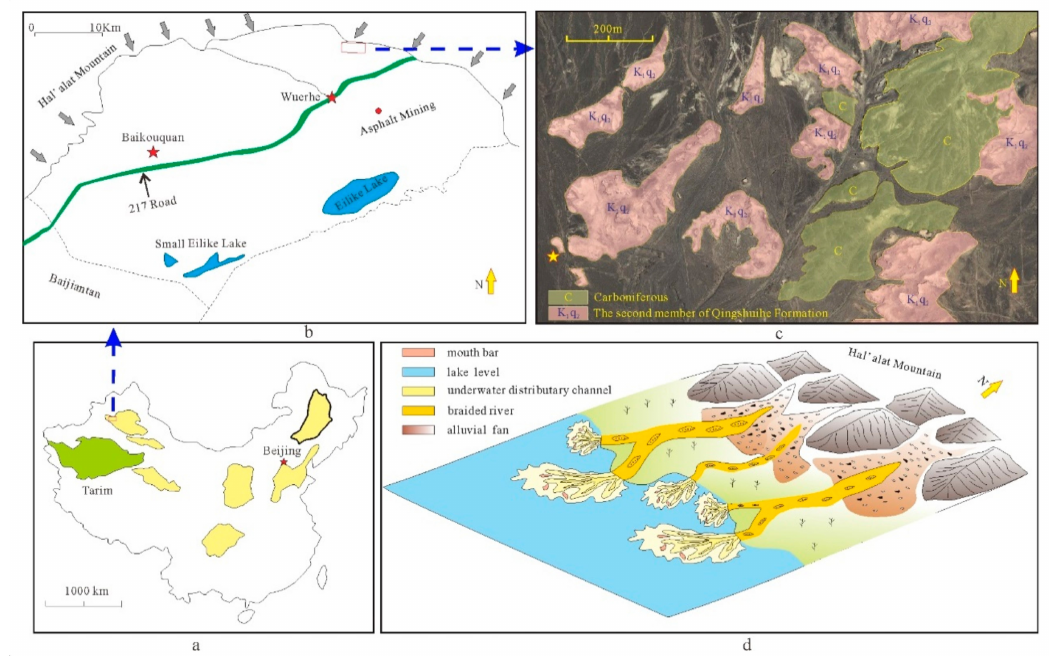
Figure 1. Location of the study area and sedimentary environment. ( a – c ) The location of the study area. ( d ) The sedimentary environment. K 1 q 2 is the second member of the Qingshuihe Formation. C is Carboniferous.